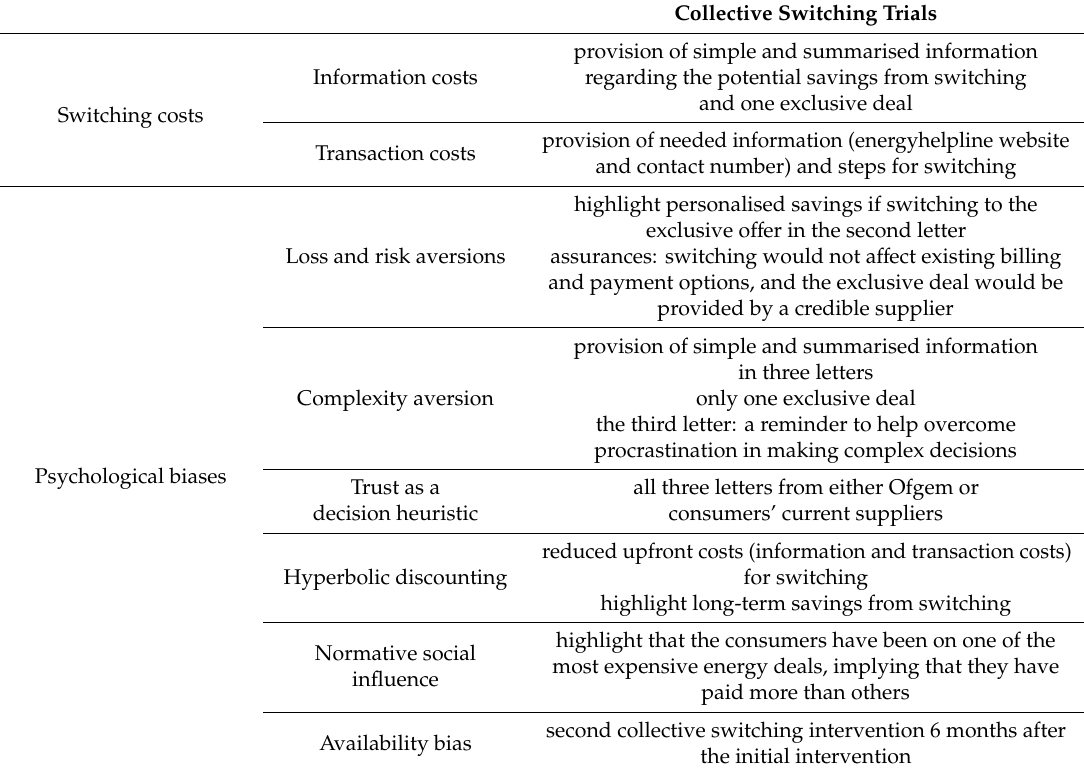
Table 3. The Collective Switching trials: Key